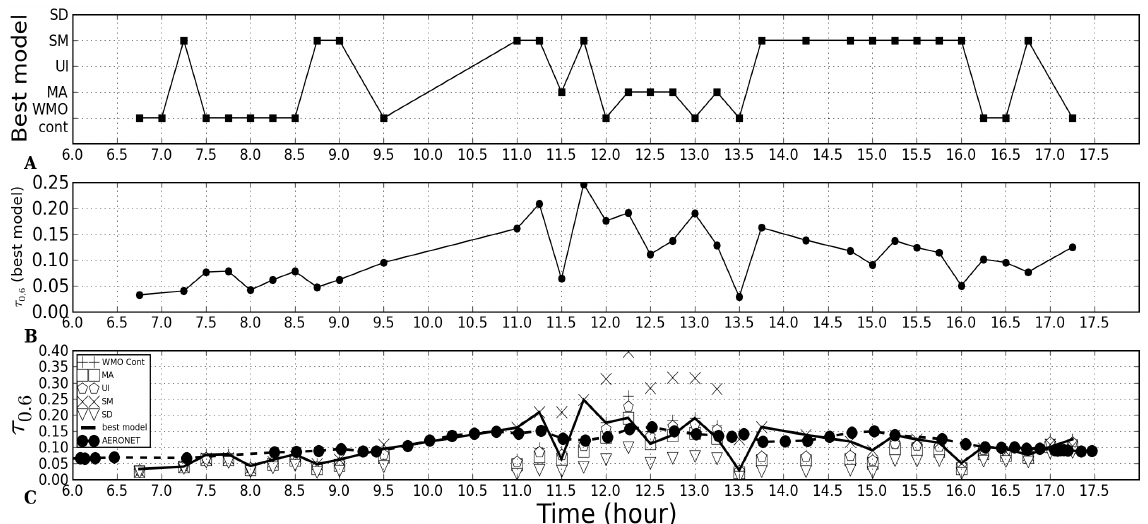
Fig. 7. Temporal evolution of aerosols parameters retrieved over Rome on the 20 July 2006. (A) Best aerosol model retrieved by the algorithm (see Table 1). (B) SEVIRI best model aerosol optical thickness at 0.6µm. (C) Aerosol optical thickness for each model (symbol): WMO continental (plus), Moderatly Absorbing (square), Urban Industrial (pentagon), Smoke (cross), Spheroidal Dust (triangle). AOT best model (black line) and AOT AERONET (black circle).